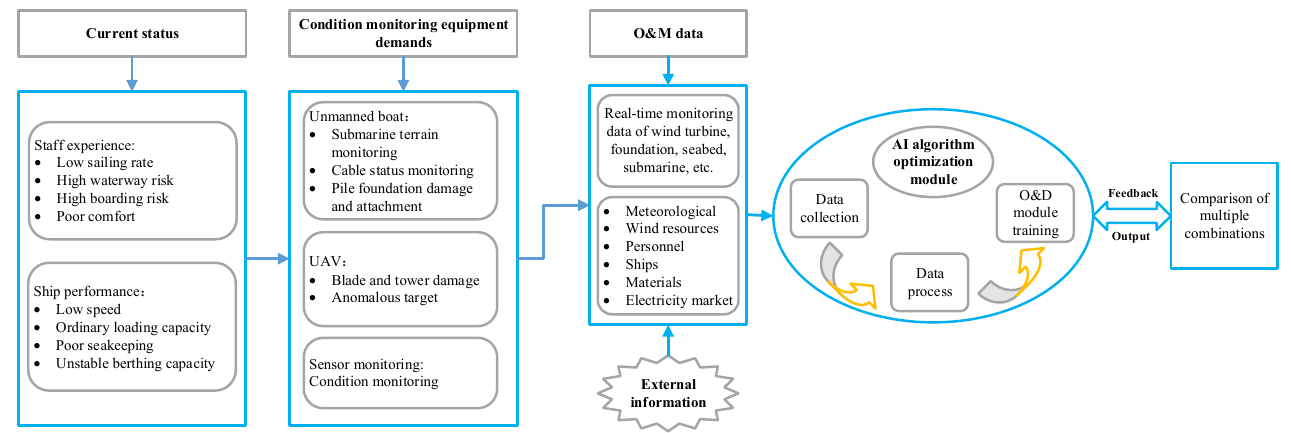
Figure 7. Development trend of operation and maintenance of offshore wind farms.